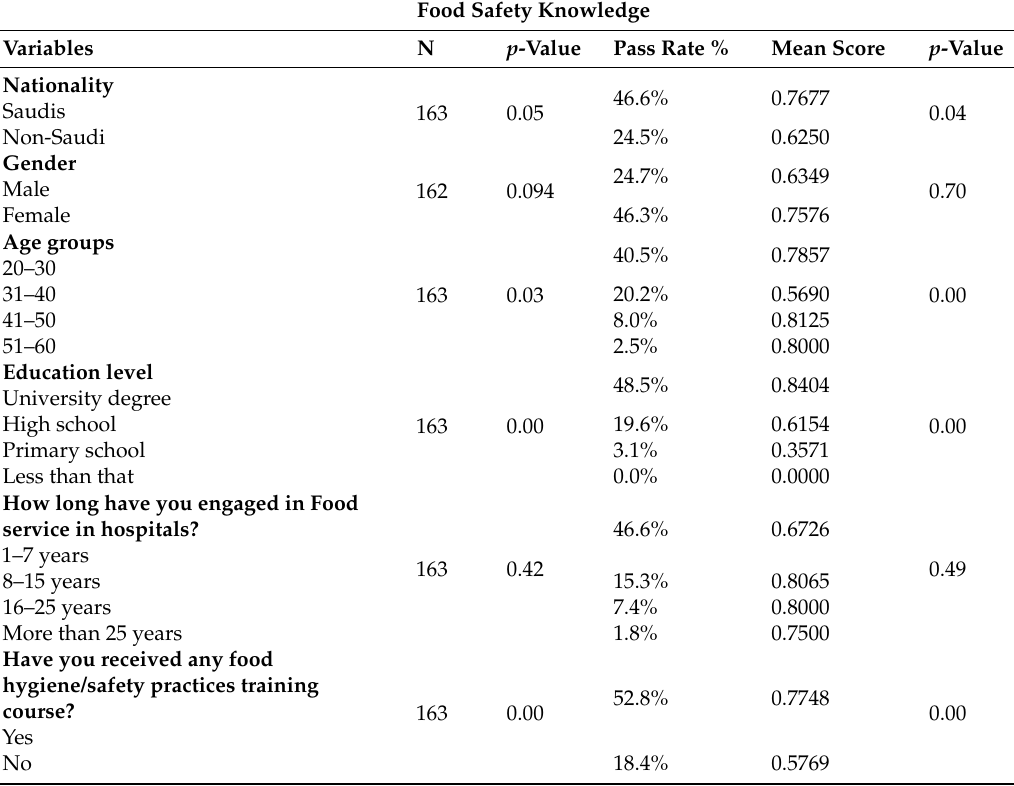
Table 7. Association between the demographic characteristics of participants and Food Safety